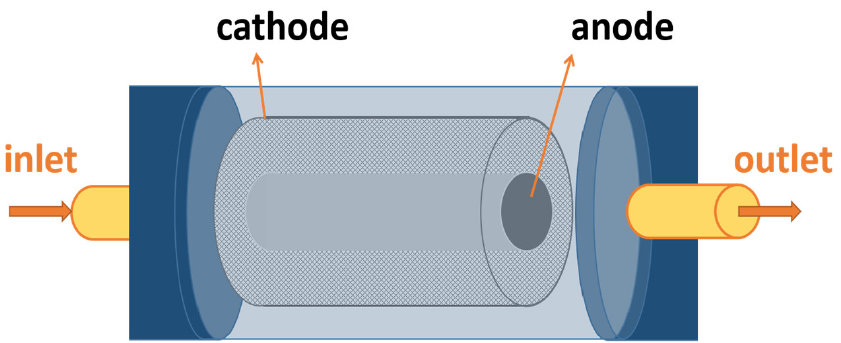
Figure 4. Schematic diagram of traditional tubular ECRs.